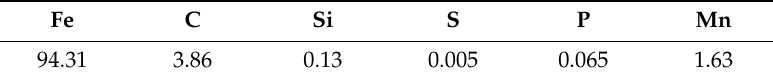
Table 5. Major element compositions of iron nuggets.